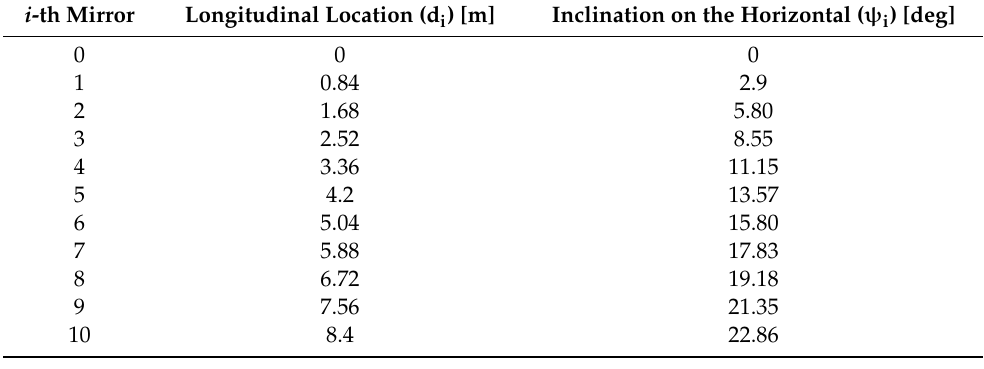
Table 2. Position of the primary mirrors at solar noon ( ω = 0; Γ = 0.5753).